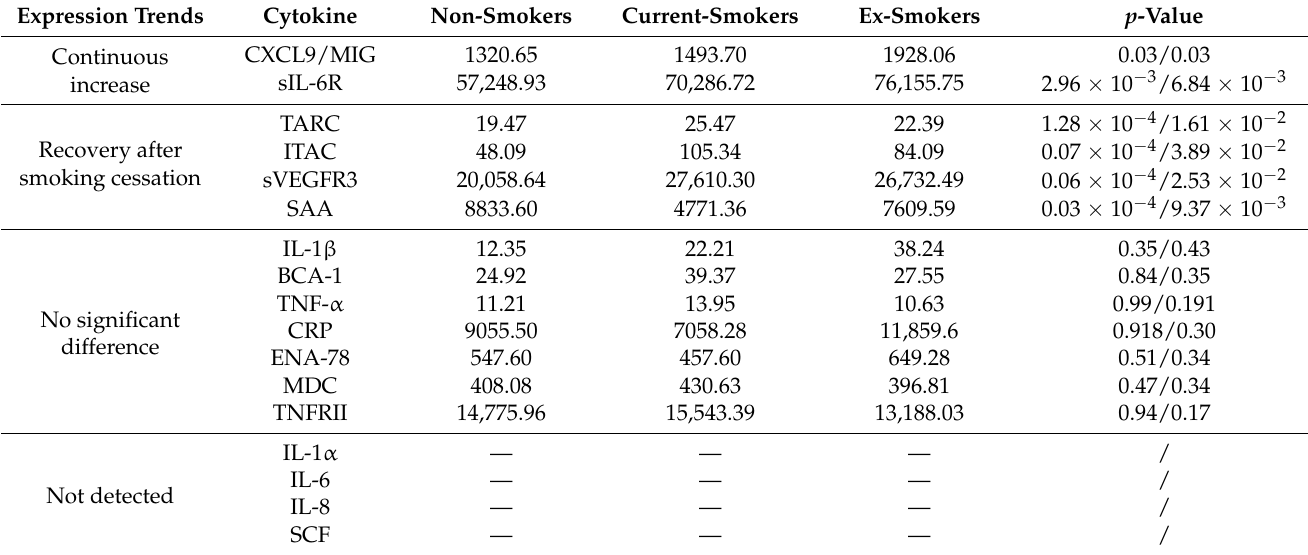
Table 2. Expression of cytokines and chemokines in three groups